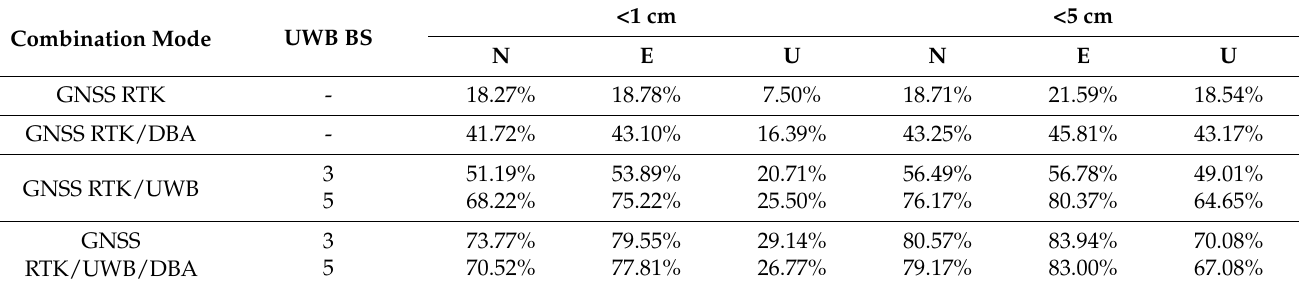
Table 5. Statistics of the GNSS RTK/UWB/DBA fusion positioning model error distribution intervals in the N/E/U directions at a 50 degree elevation mask